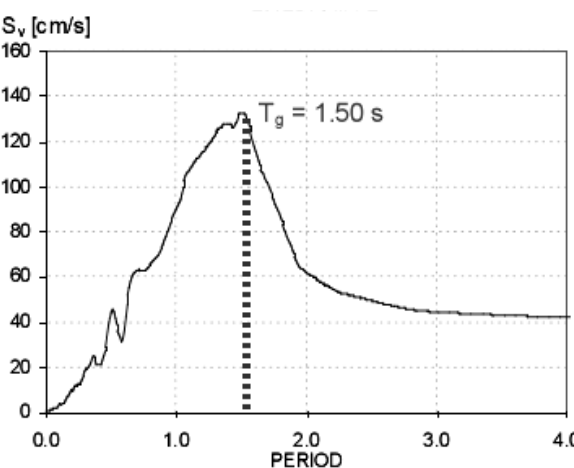
Fig. 15. Predominant ground motion period for the assumed soil record obtained from PEER